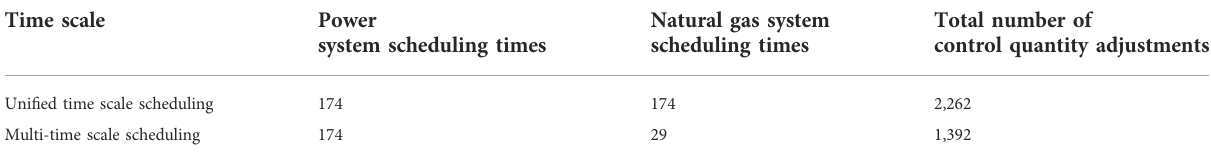
TABLE 4 Comparison of control quantity adjustment times under different scheduling methods.